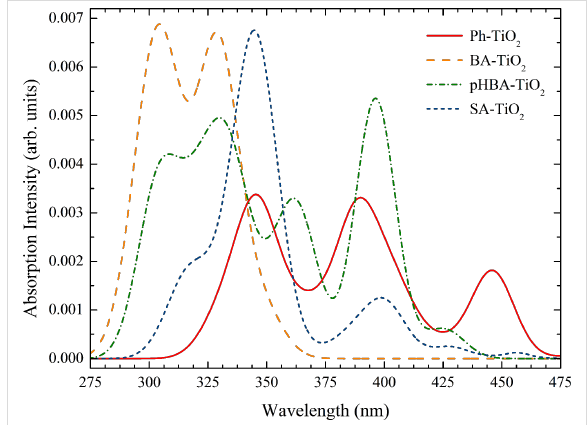
Figure 7: Simulated UV–vis absorption spectra of the pollutants bound to the TiO 2 cluster, calculated by TD-DFT in water. The spectral lines were convoluted with Gaussian distributions of 20 nm linewidth at half